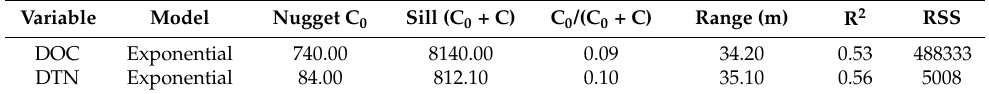
Table 3. Parameters of semi-variogram models for DOC and DTN. Nugget: the undetectable measurement error, inherent variability, or variation within the minimum sampling distance. Sill: total variation. Nugget sill ratio: the degree of spatial variability. RSS: residual sum of squares.